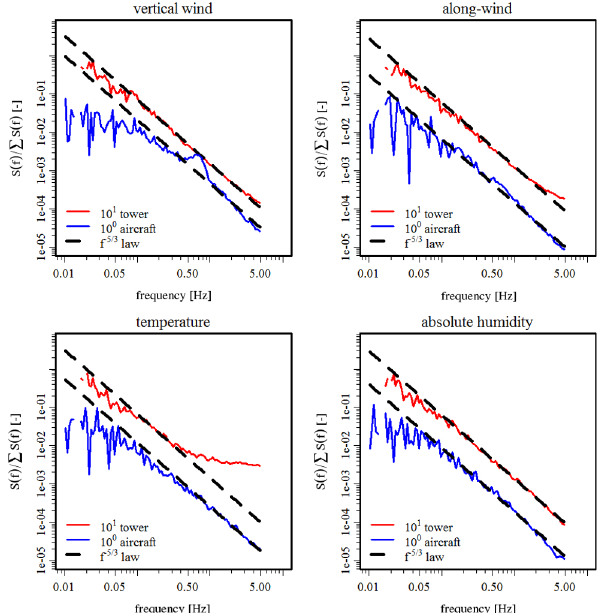
Fig. 3. Average power spectra of all measurements between tower and WSMA. To improve legibility, the tower data are offset by one order of magnitude. Also shown is the f − 5 / 3 law of isotropic tur- bulence (dashed line). Additional information is given in the text.